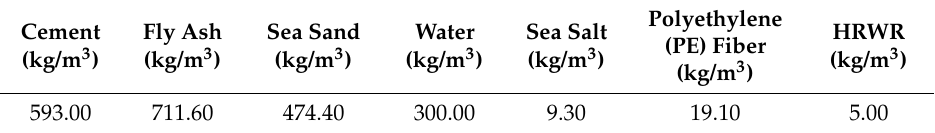
Table 2. Mix proportion of ultra-high ductile cementitious composite (UHDCC).